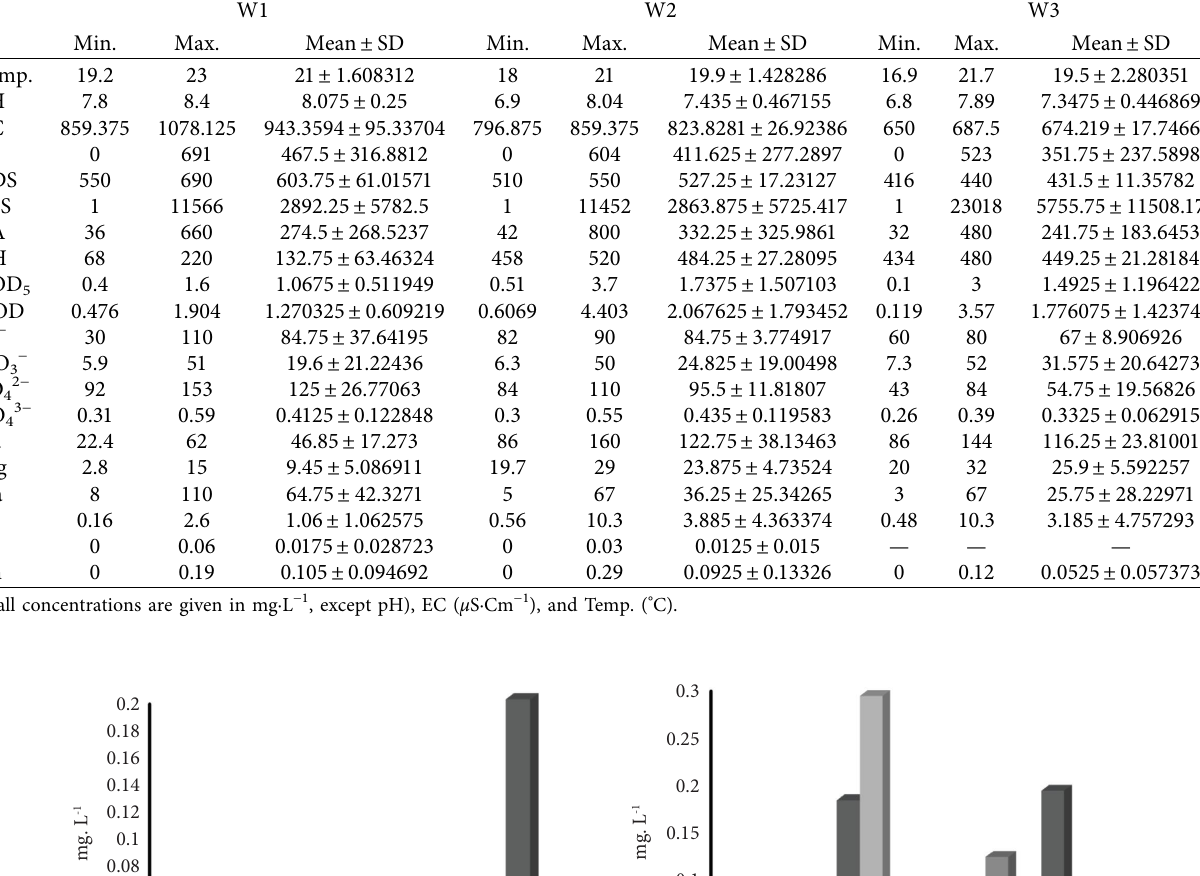
Table 4: Physicochemical parameters of three groundwater (tube well) samples surrounding the open dump area during four seasons of the year 2021-2022. W1 W2 W3 Min. Max. Mean ± SD Min. Max. Mean ± SD Min. Max. Temp.